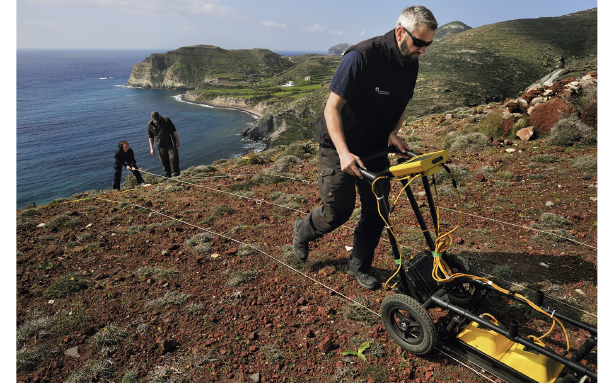
Figure 3: Laser scanning with a Riegl VZ-400 scanner in front of Westhouse on Triangle square of Akrotiri.